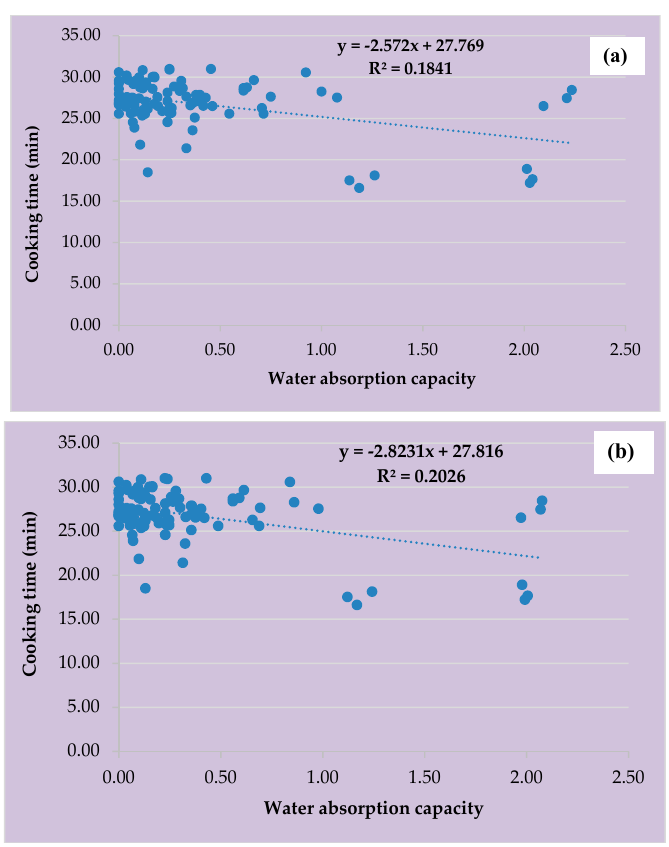
Figure 5. Correlation between water absorption and cooking time for the Vigna reticulata accessions. ( a ) Plotted with data from Site A; ( b ) plotted with data from Site B.